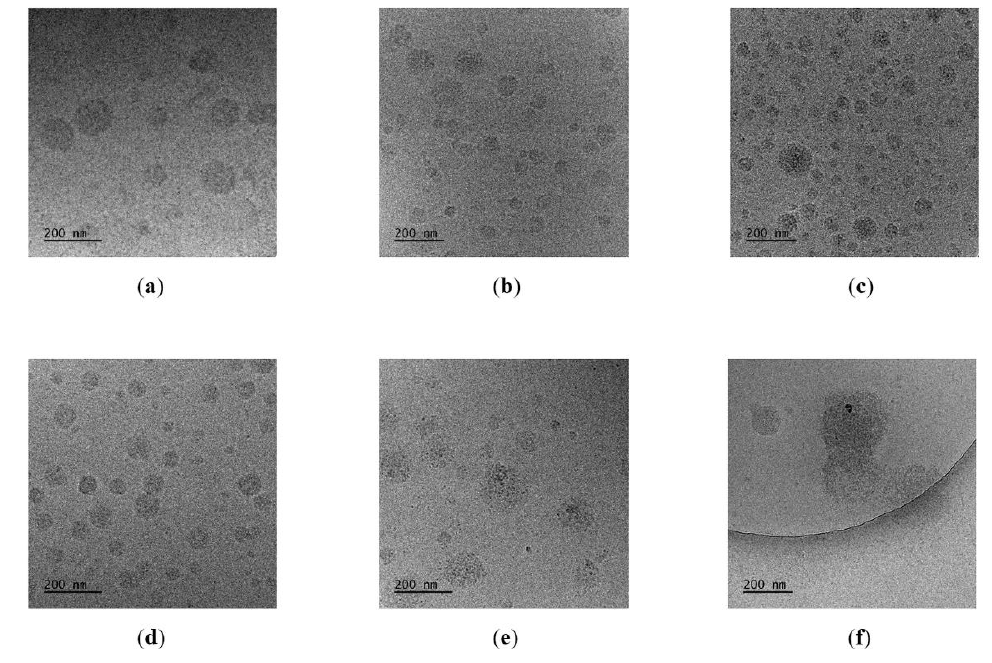
Figure 6. CryoTEM images of ( a ) R1, ( b ) R2, ( c ) R3, ( d ) R4, ( e ) R5, (f) R6 nanogels (C = 0.5 g/L). 477